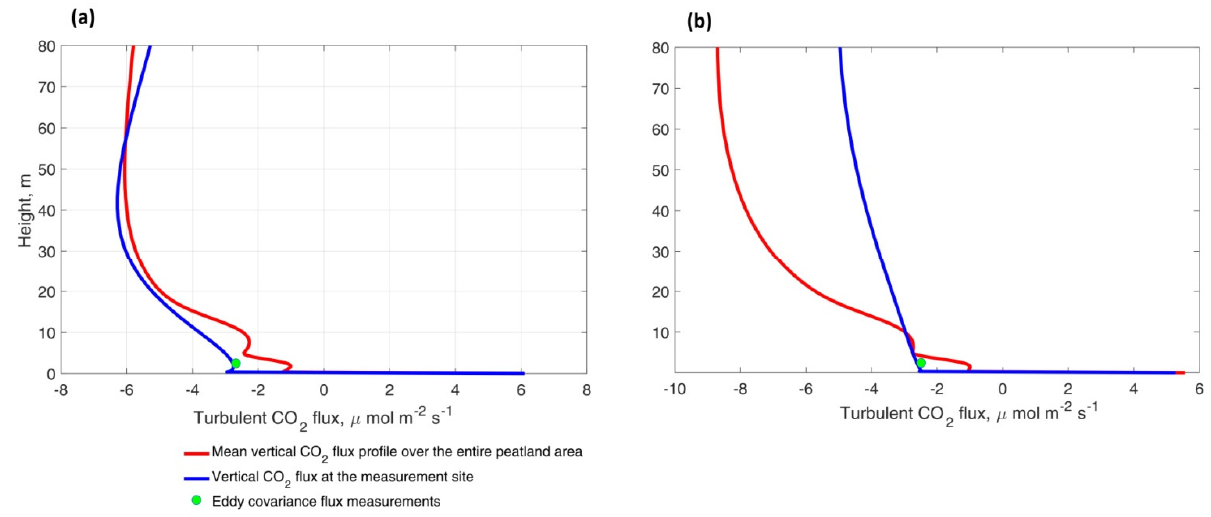
Figure 9. Modeled vertical profiles: CO 2 fluxes at the eddy covariance measurement site in the southern part of the peatland and average CO 2 fluxes over the entire peatland area under ( a ) southwest (25 June 2016 at 14:00) and ( b ) northwest wind directions (28 June 2016 at 13:30). Green points indicate the eddy covariance flux measurements at the height of 2 m above the ground.